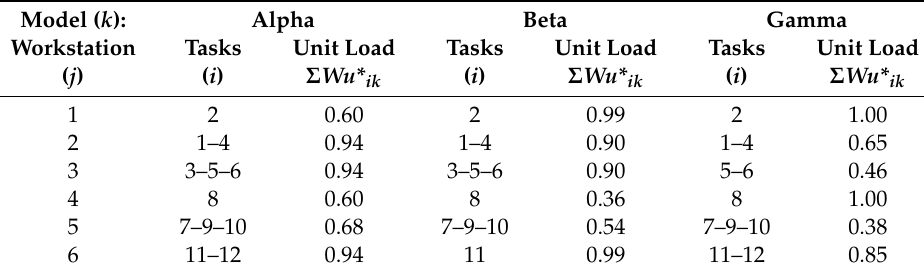
Table 10. Optimal assignment of tasks to workstations.